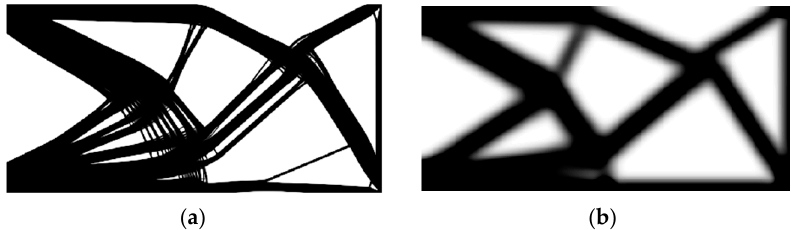
Figure 20. The final topology obtained using [35] with a small ( a ) and a large ( b ) filtering radius.